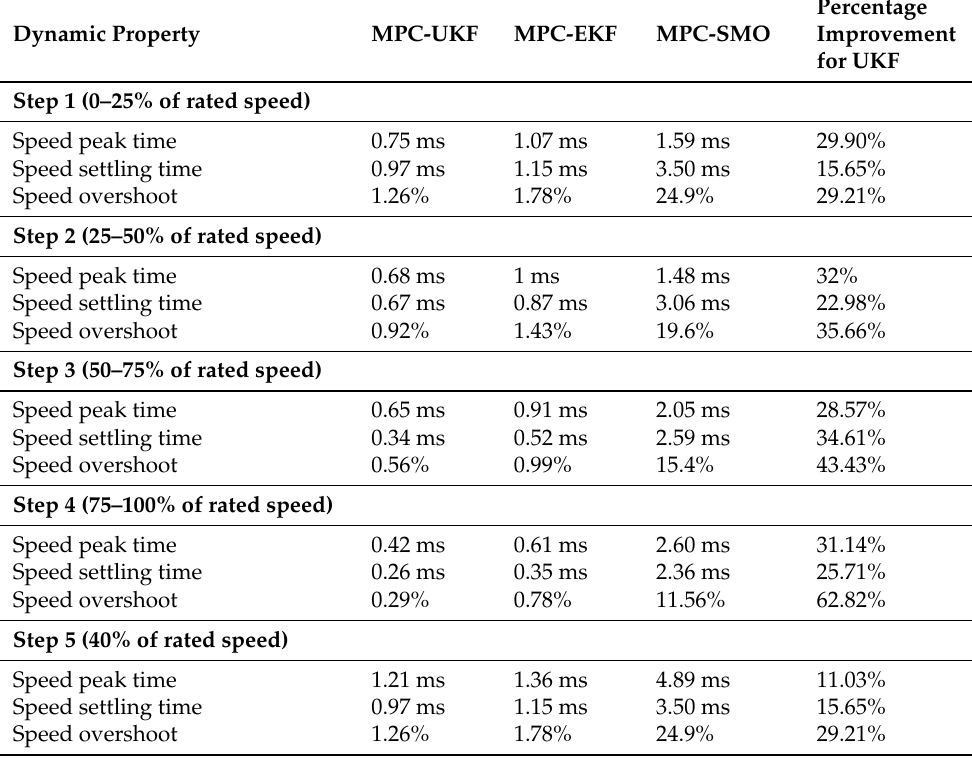
Table 4. PMSM parameters used in the